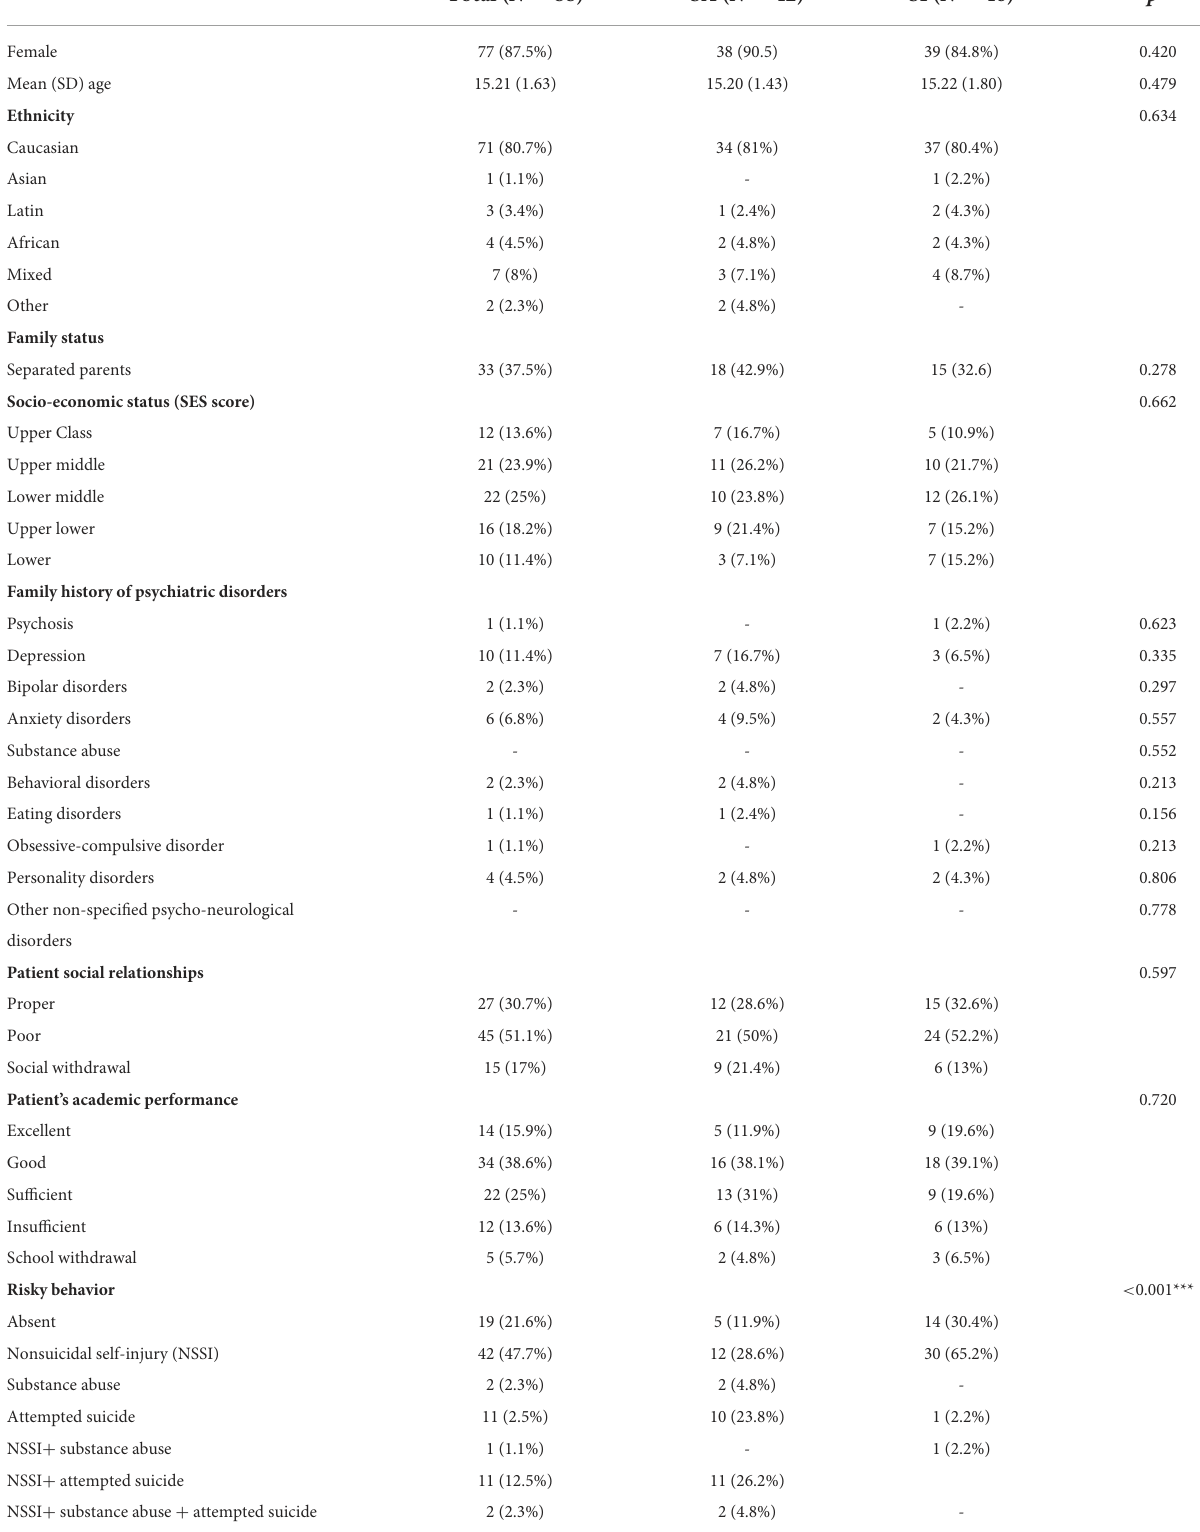
TABLE 1 Sociodemographic and anamnestic data in the total sample and the two